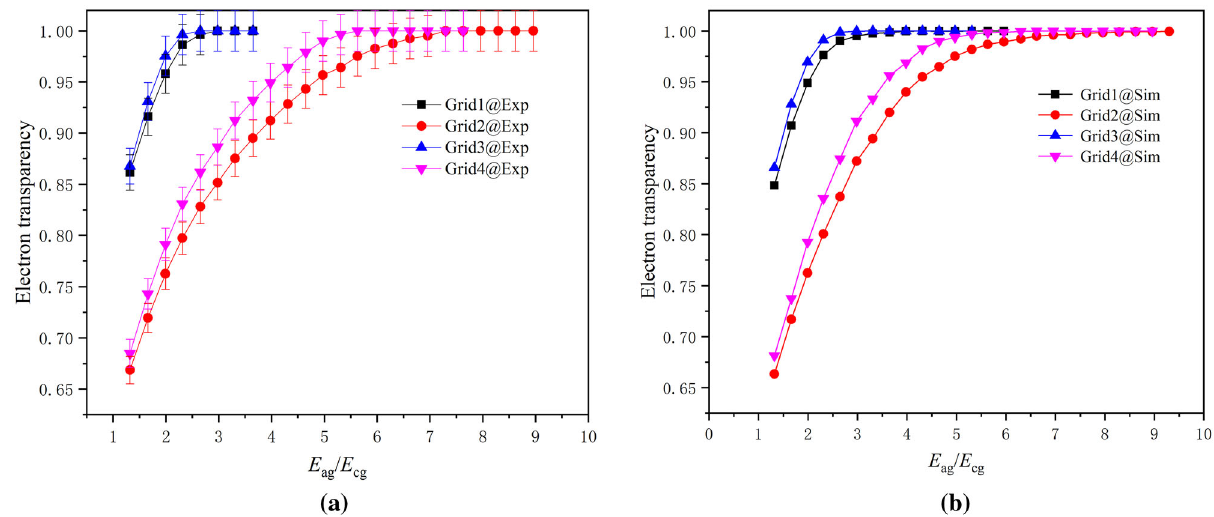
Fig. 7 Experimental ( a ) and simulated ( b ) electron transparency of different grids as a function of E ag / E